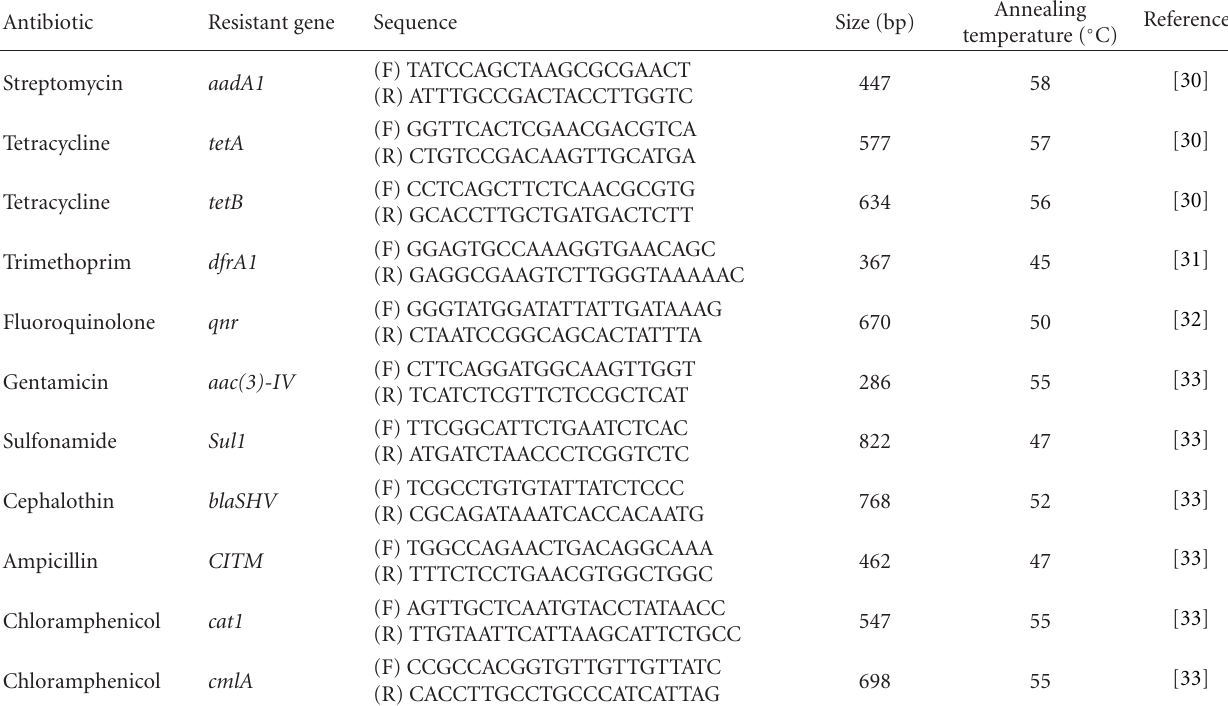
Table 2: E. coli -resistant antibiotic genes, primer sequence, and product